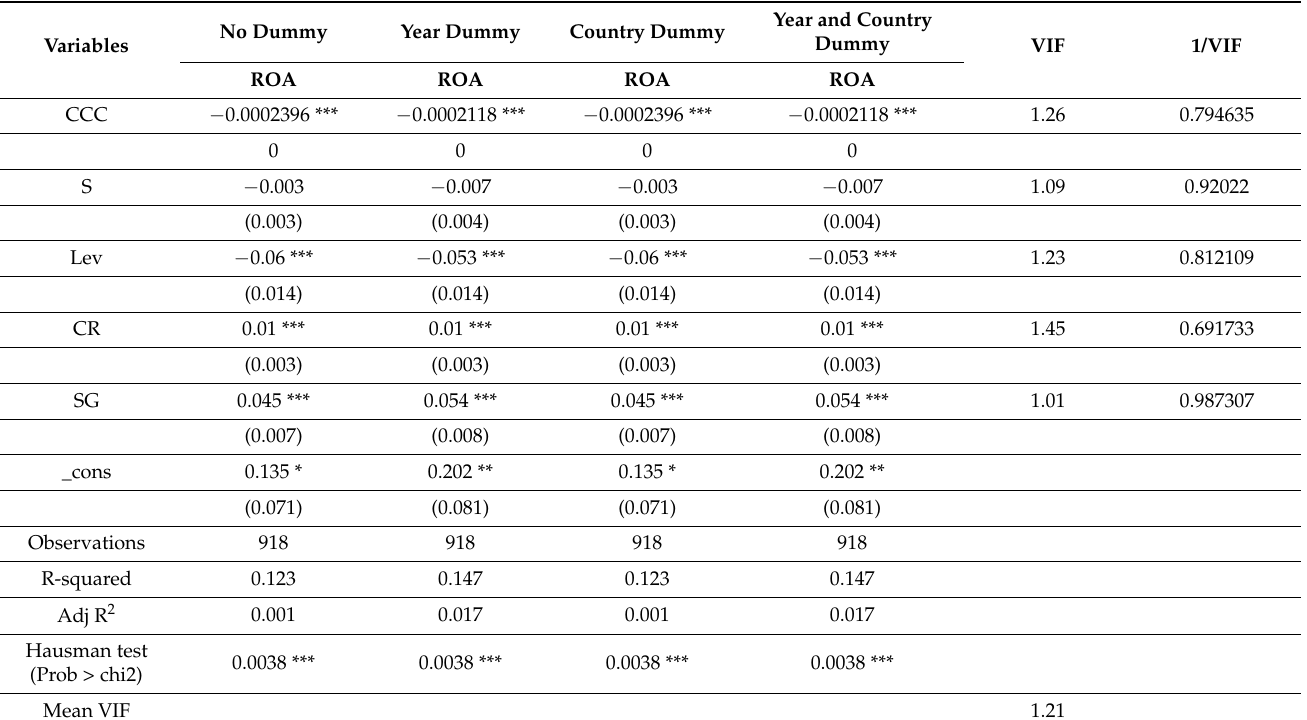
Table 12. Results of the fixed effects of CCC on ROA, as per panel data regression (pre-pandemic period,